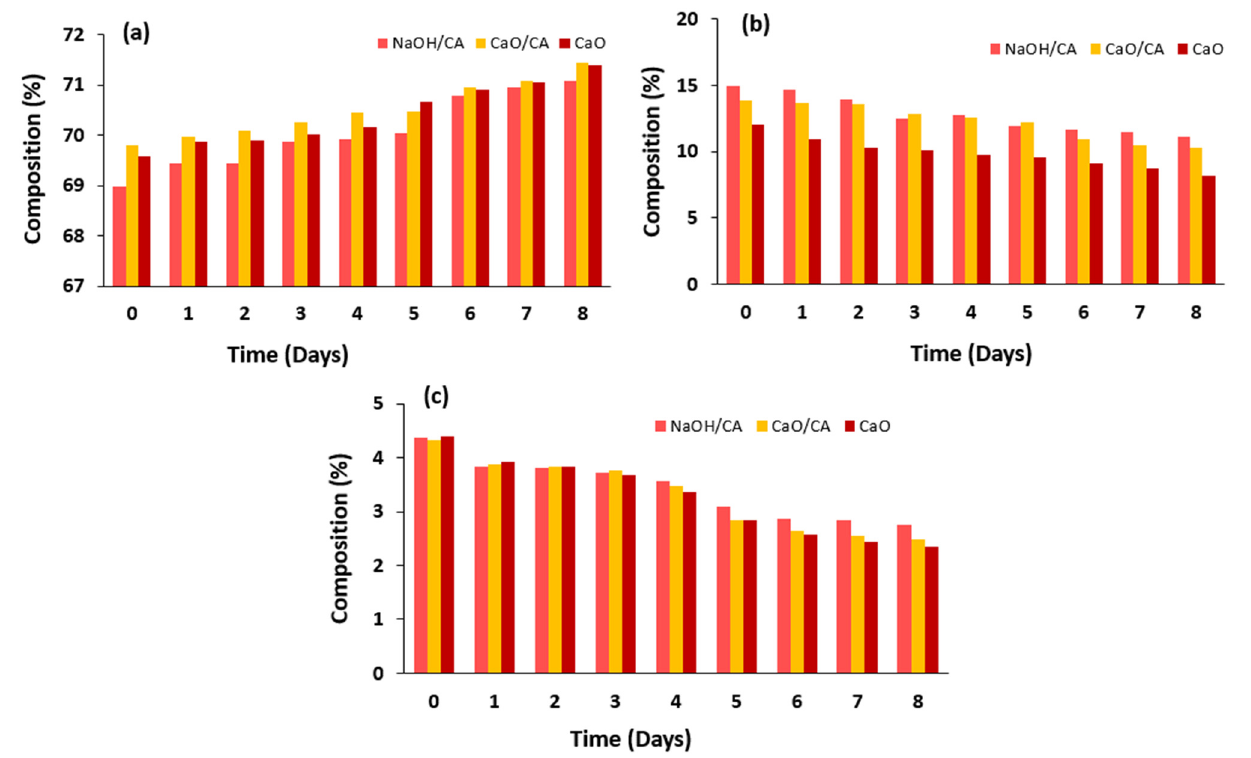
Figure 10. Composition of fatty acids in degraded biodiesel. ( a ) Saturated fatty acids, ( b ) monounsaturated fatty acids and ( c ) polyunsaturated fatty acids.